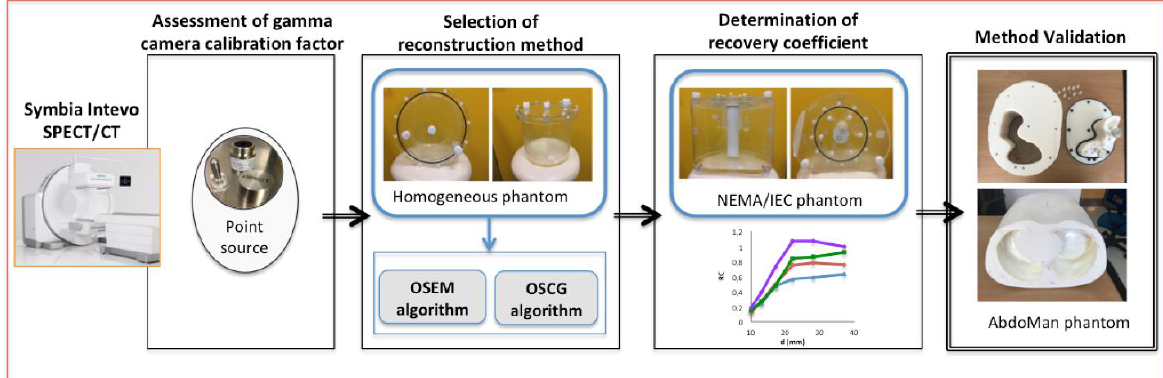
Figure 1. Experimental materials and methods described in the present work.